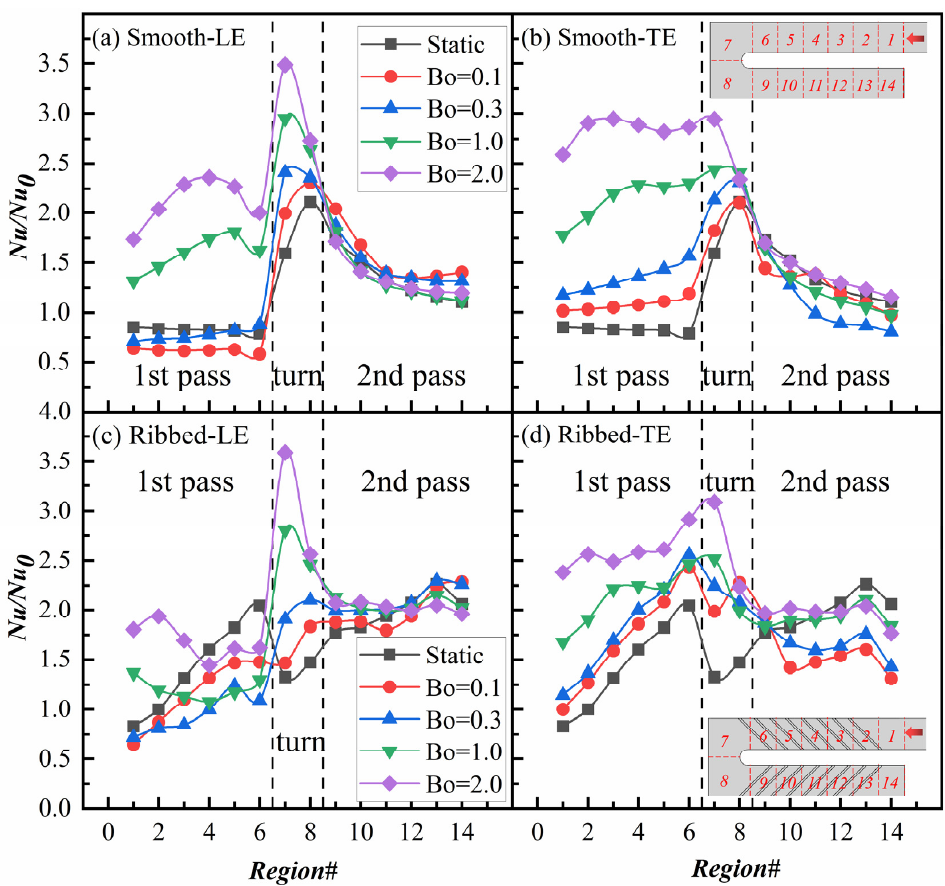
Figure 12. Streamwise profile of area-averaged Nu / Nu 0 .